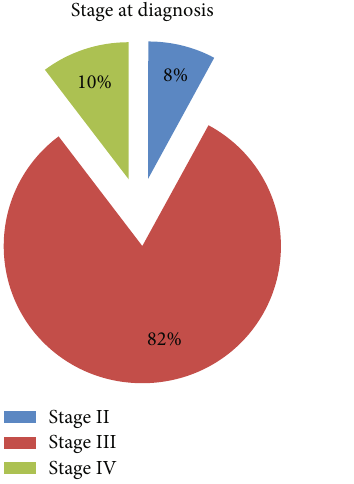
Figure 1: Stages of breast cancer at diagnosis (SPHMMC, 2018).